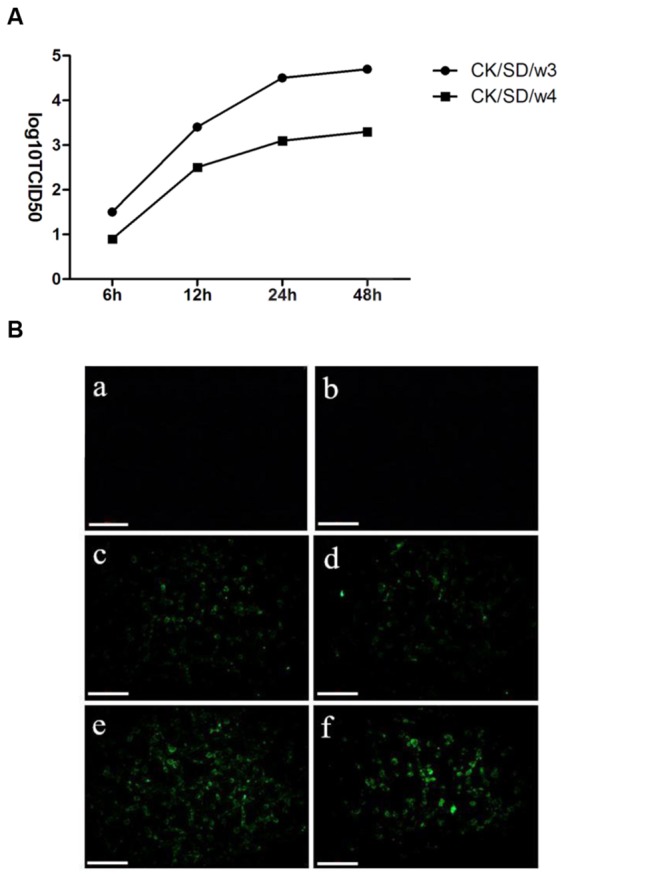
Kinetics of replication of CK/SD/w3 and CK/SD/w4 in TC-1 cells. (A) Infectious viruses from TC-1 cultures were harvest at 6, 12, 24, and 48 hpi, respectively, and titrated at MDCK cells; (B) CK/SD/w3 and CK/SD/w4 infection in TC-1 cells. CK/SD/w3 influenza virus (left); CK/SD/w4 influenza virus (right). Cells were infected with the viruses for 6 and 12 h, respectively, and stained with an fluorescein isothiocyanate (FITC)-anti-influenza A hemagglutinin (HA) antibody. Subsequently fluorescence images were taken (magnification, ×200; scale bars: 20 μm): (a,b) uninfected cells; (c,d) 6 h after infection; (e,f) 12 h after infection.